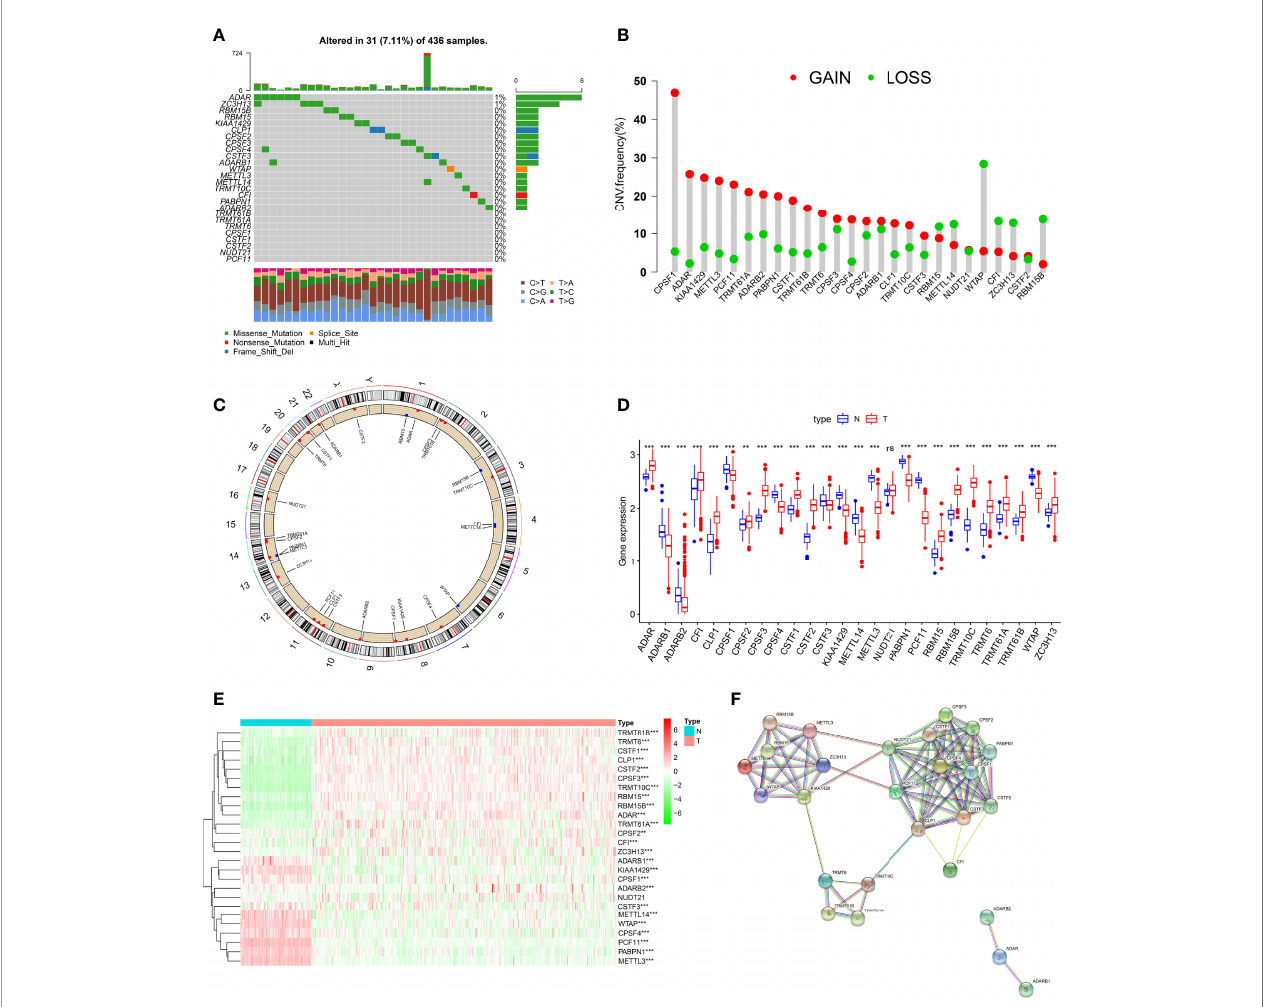
FIGURE 1 | Genetic and transcriptional alterations of RNA modi fi cation “ writers ” in ovarian cancer (OC). (A) The mutation frequency of 26 RNA modi fi cation “ writers ” in 436 OC patients from The Cancer Genome Atlas (TCGA) cohort. (B) Frequencies of copy number variation (CNV) gain, loss, and non-CNV among RNA modi fi cation “ writers. ” (C) Locations of CNV alterations in RNA modi fi cation “ writers ” on 23 chromosomes. (D) Expression distributions of 26 RNA modi fi cation “ writers ” between normal and colorectal cancer (CRC) tissues. (E) Heatmap showing expression pro fi les of 26 RNA modi fi cation “ writers ” in OC and normal tissues. (F) The protein – protein interaction (PPI) network of RNA modi fi cation “ writers ” . Adjusted p-values were shown as ns, not signi fi cant; ** p <0.01; *** p